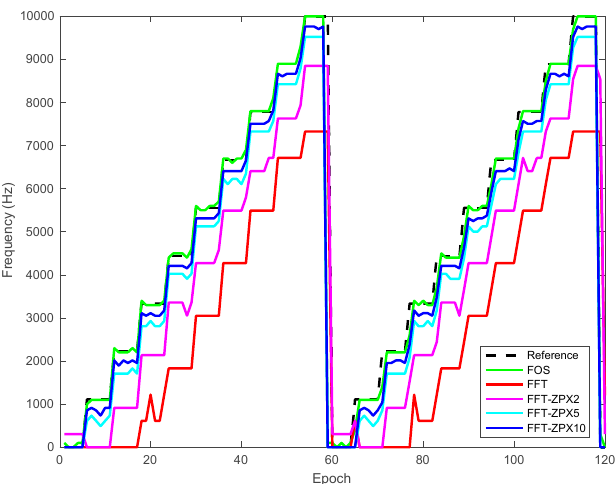
Figure 9. Estimated swept jamming signal frequency using the proposed method, FFT, and zero- padding FFT-based anti-jamming algorithms.